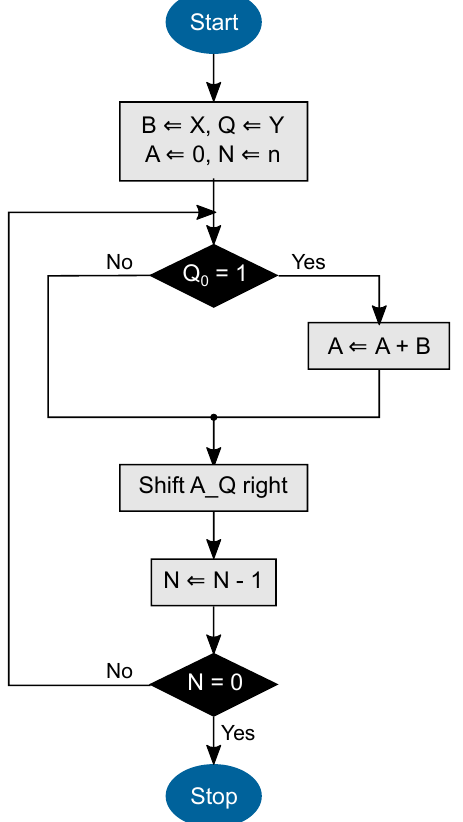
Figure 4. “Shift-and-Add” multiplication algorithm based on Ref. [24]. The aim is to multiply the n -bit long numbers X and Y . The product register A is initialized with 0 and the counter N with n